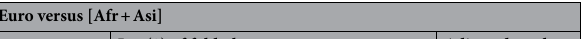
DM/Hypoxia, Euro versus [Afr + Asi] Gene Log(2) of